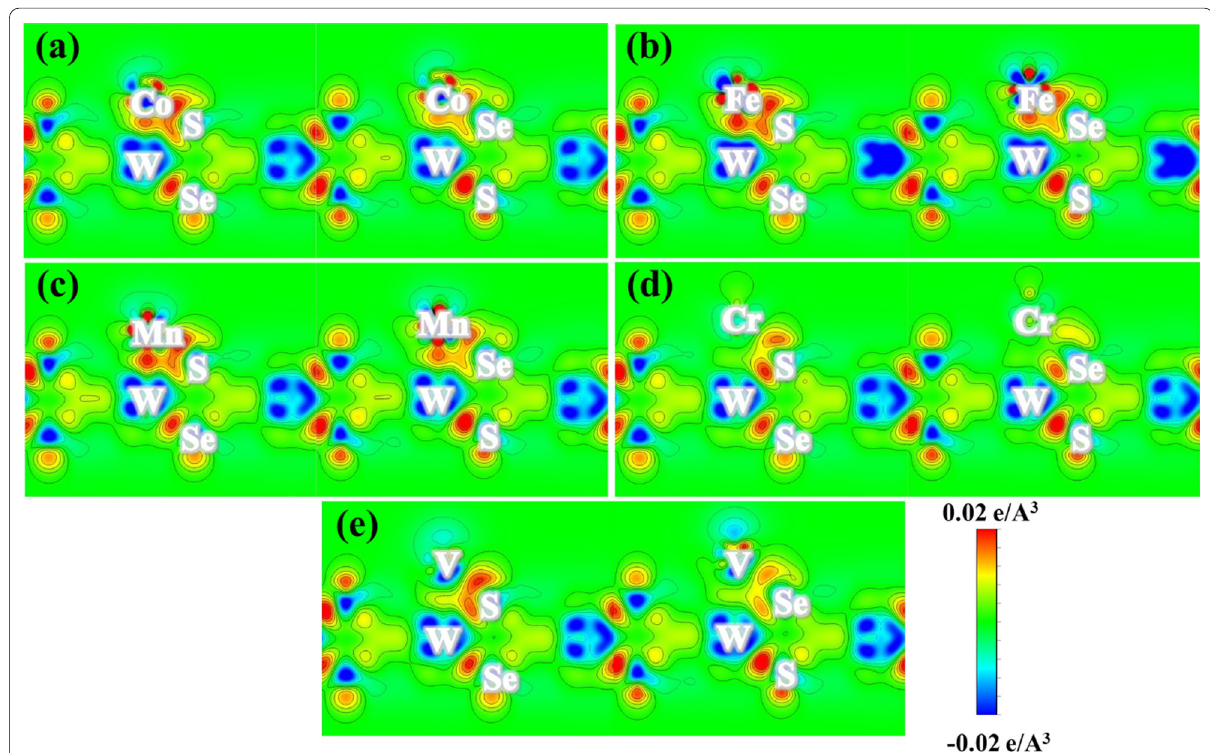
Fig. 4 Differential charge densities of different TM atom-adsorbed systems. a Co; b Fe; c Mn; d Cr; e